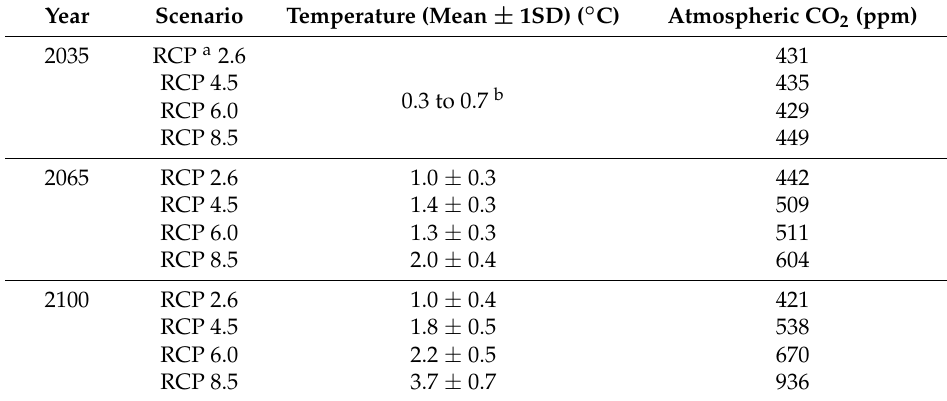
Table 2. Change in global mean surface temperature and atmospheric CO 2 concentrations for mid-century and end of century, relative to the period from 1986 to 2005